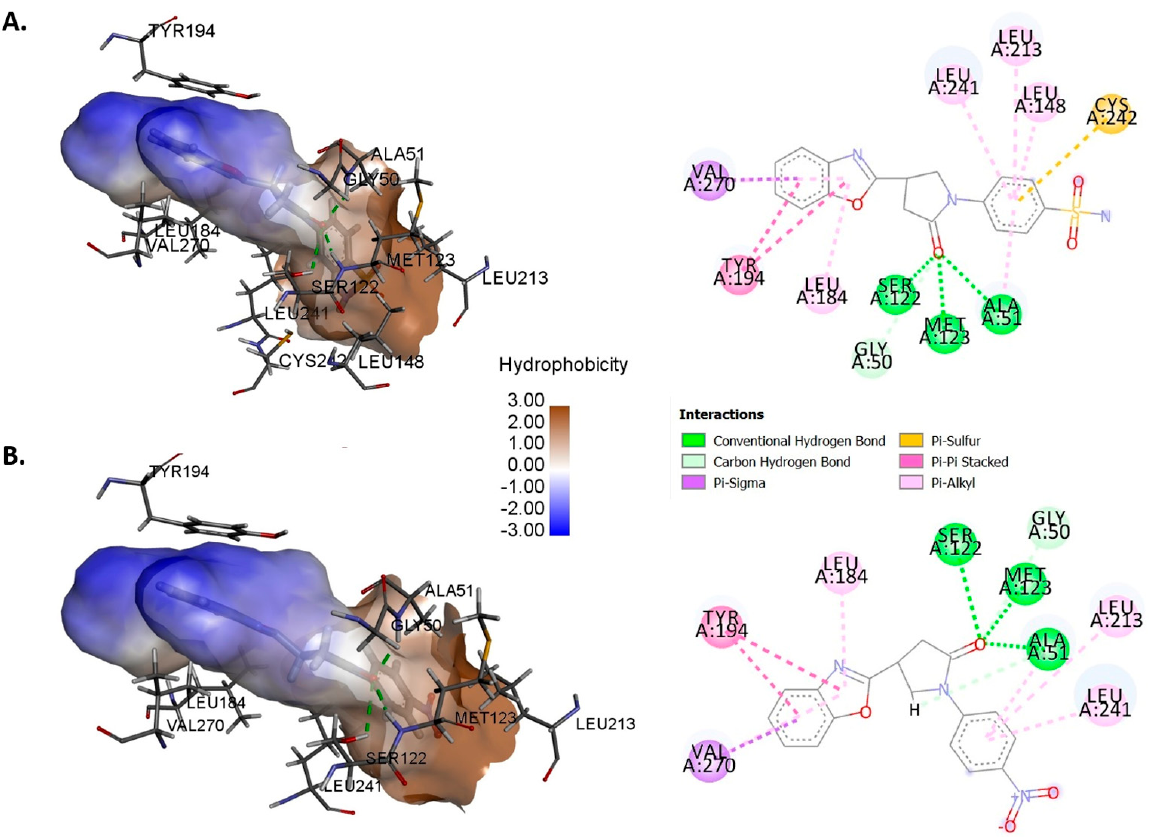
Figure 4. Glide XP docking; 3D and 2D representation of the binding pattern of compound 19 ( A ), and 20 ( B ) in the catalytic site of MAGL. The picture (2D and 3D) for the docked complexes were obtained from Discovery studio visualizer 2020. The hydrophobicity was calculated from the default option available.